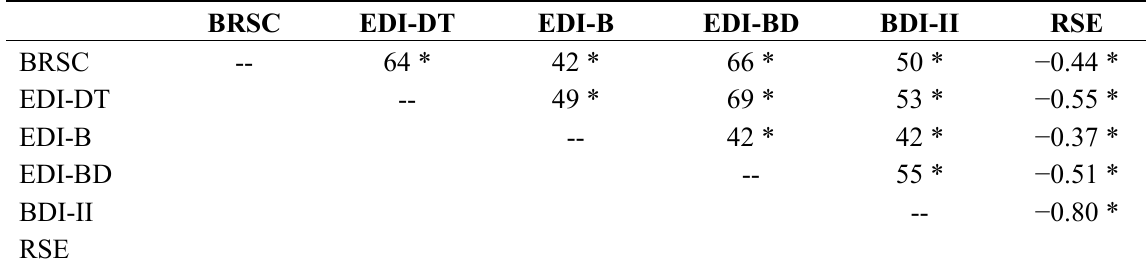
Table 2. Correlation Matrix for Study